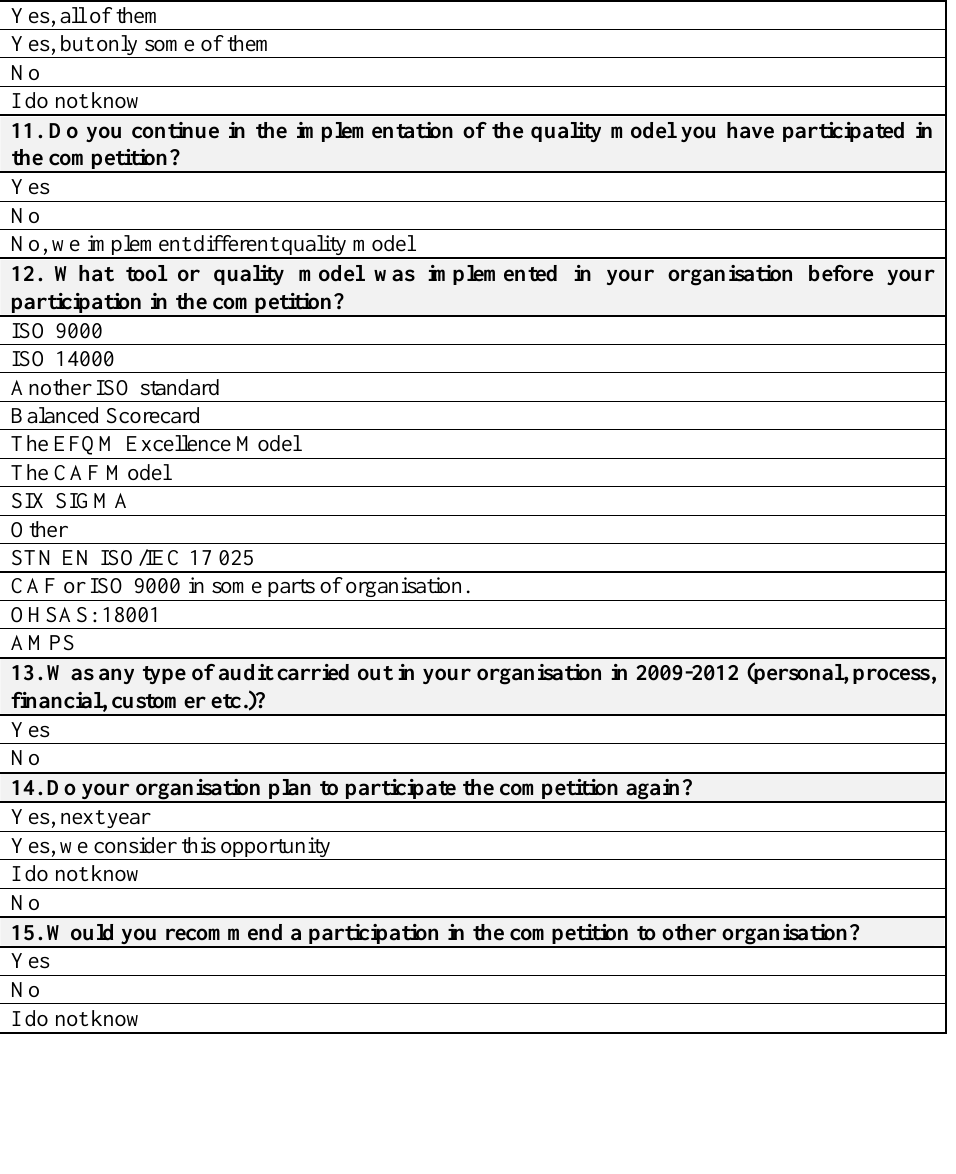
Balanced Scorecard The EFQM Excellence Model The CAF Model SIX